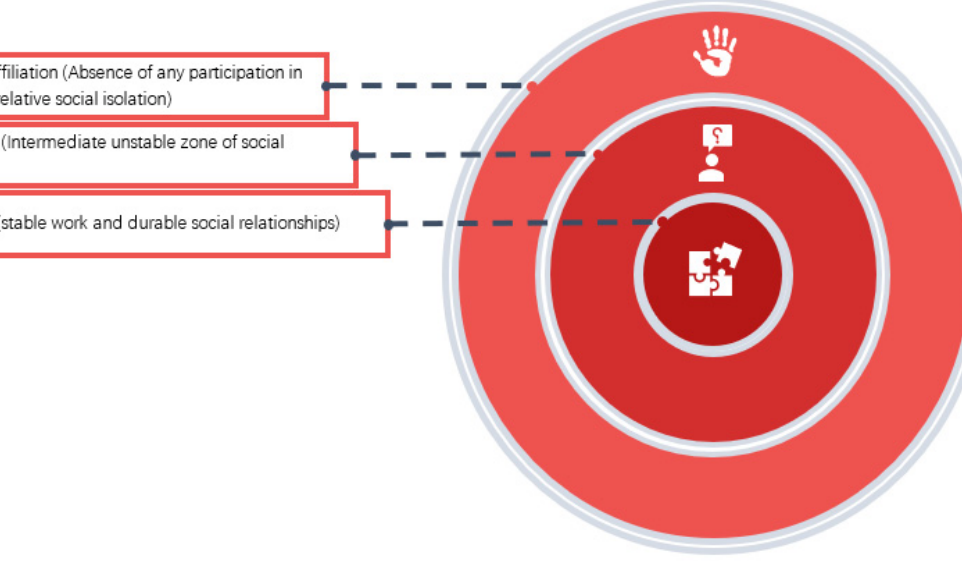
Figure 1. The three zones of social cohesion, according to Castel. Source: Castel